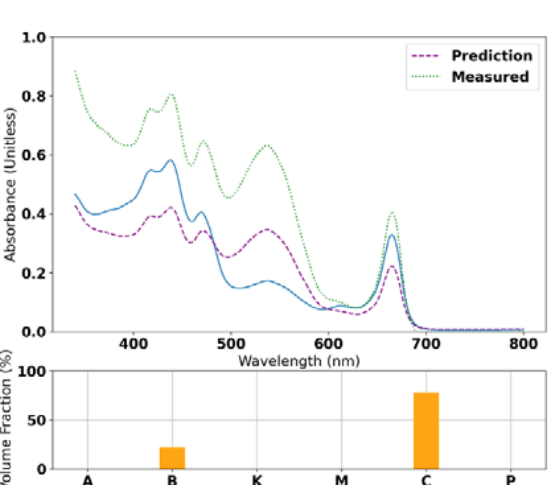
Figure A1. A linear rule of mixtures is applied to predict the absorbance profile (the blue curve) of a dye combination containing Betalin (B) and Chlorophyll (C). Notice that this profile exactly matches the data shown in Figure 5 for volume fractions of 100% Betalin and 100% Chlorophyll. The purple curve shows the predicted absorbance profile value for 50% Betalin and 50% Chlorophyll while the green curve shows the empirically measured profile for this same combination. The incommensurability of these two curves indicates that, while simple, a linear rule of mixtures is not adequate to accurately predict the absorbance profiles of unique dye combinations. (Download the supplementary materials to review this animation).